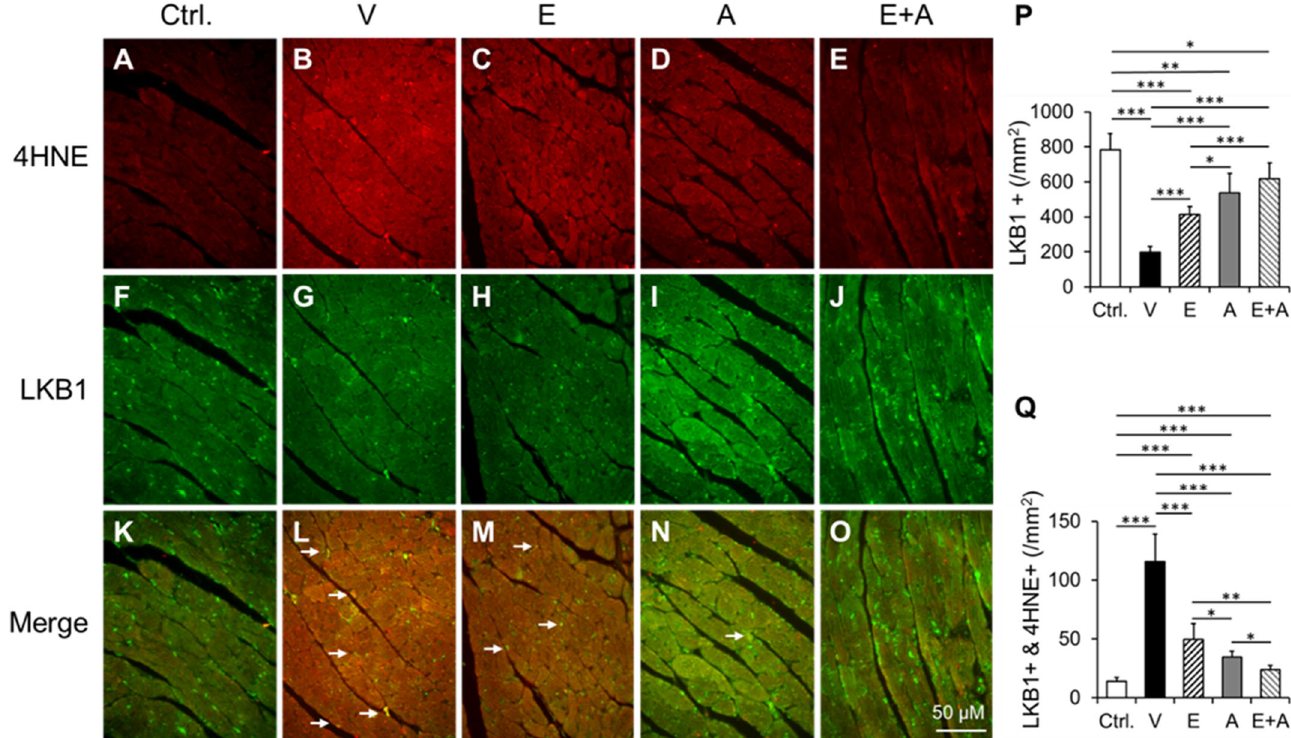
Figure 7. Co-immunostaining of LKB1 and 4HNE protein adducts in the cardiac sections. Repre- sentative micrographs of cardiac sections with immunostaining of LKB1 and 4HNE adducts and their merging from non-diabetic ALDH2*2 control mice (Ctrl) ( A , F , K ), ALDH2*2 diabetic mice ex- hibiting HFpEF with vehicle (V) ( B , G , L ), (E) ( C , H , M ), (A) ( D , I , N ) and E + A ( E , J , O ) treatments. The white arrows show co-immunopositivity of LKB1 and 4HNE protein adducts. Quantification data of LKB1+ ( P ) and co-immunostaining of 4HNE with LKB1 ( Q ) was shown. Data are presented as mean ± standard error of the mean (SEM). n = 4. * p < 0.05, ** p < 0.01 and *** p < 0.001 refer to the difference between individual groups as shown in ( P , Q ).